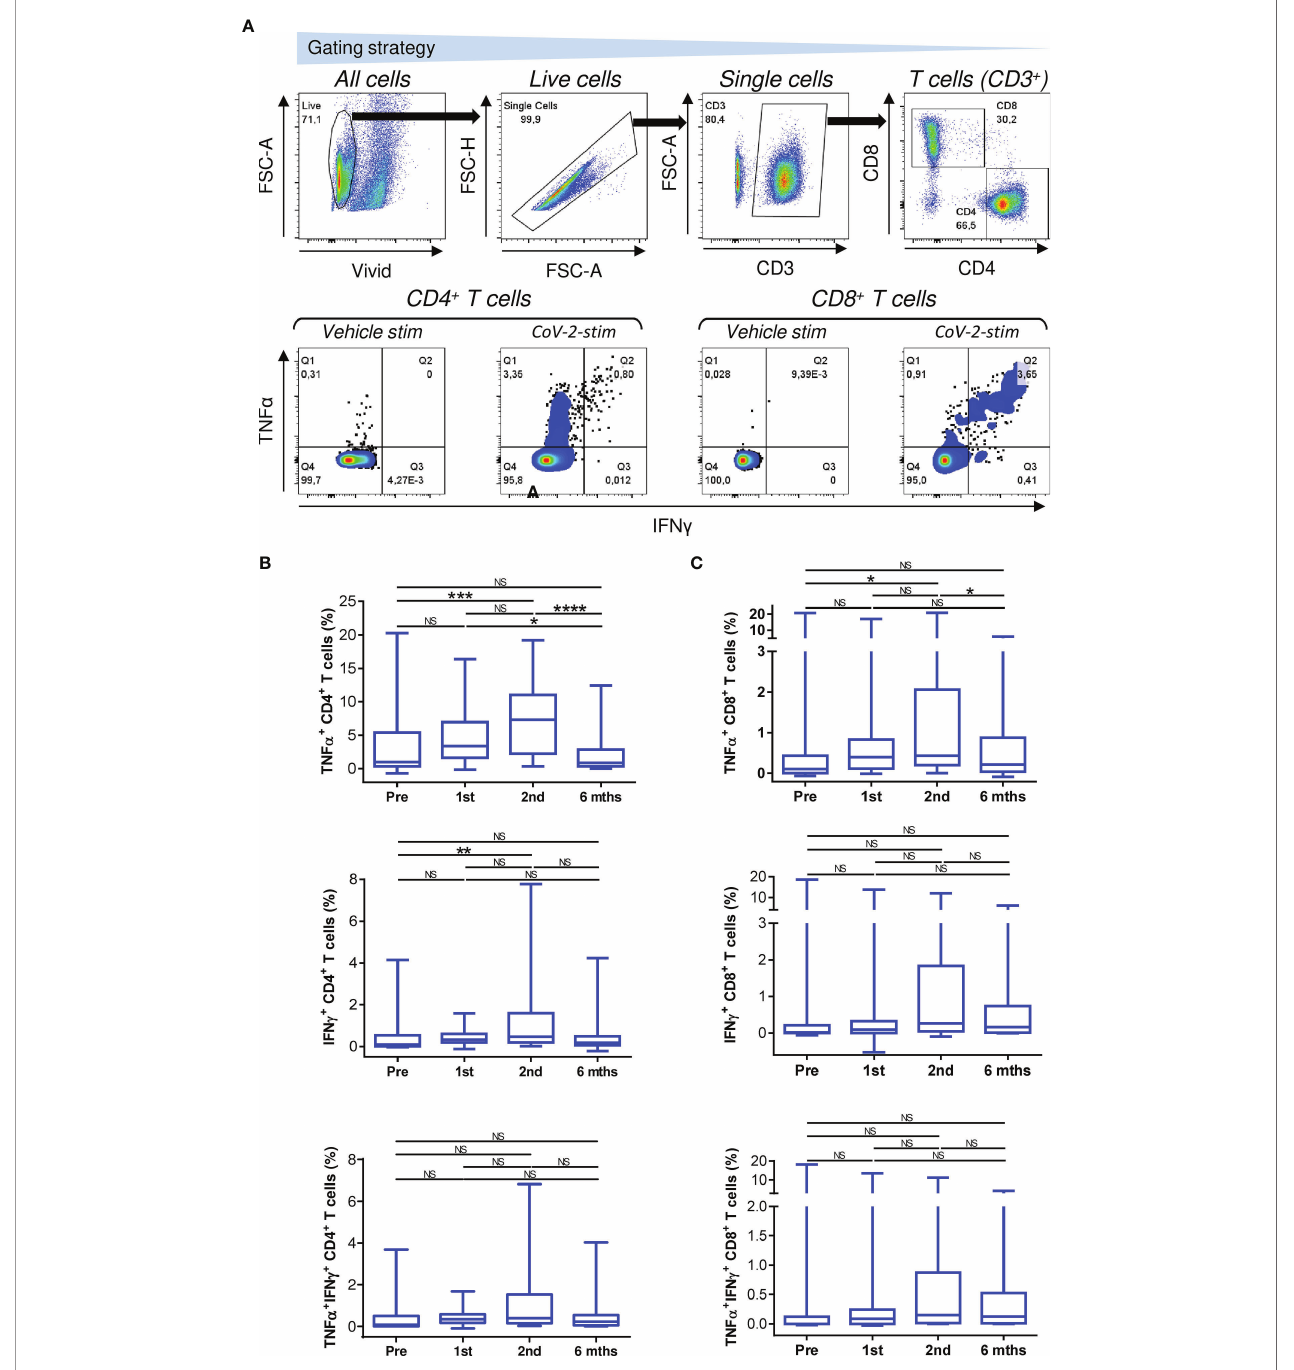
FIGURE 2 | Reactivity of enriched PBMCs to SARS-CoV-2 spike glycoprotein peptides. (A) The gating strategy for fl ow cytometry data ( top panels ). The frequencies of TNF a -, IFN g -, or TNF a /IFN g -producing CD4 + and CD8 + T cells in enriched PBMCs stimulated with vehicle (Vehicle-stim) or SARS-CoV-2 spike glycoprotein-derived peptides (CoV-2-stim) ( bottom panel s) determined by intracellular cytokine staining. The frequency of each peptide-reactive cytokine-producing T-cell population was calculated as the difference in the frequency of the cytokine-producing T cells between the vehicle- and peptide-stimulated samples. (B, C) The frequencies of peptide-reactive TNF a -, IFN g -, or TNF a /IFN g -producing CD4 + (B) and CD8 + (C) T cells before the fi rst (Pre) and second (1st) vaccine doses were administered and 4 weeks (2nd) and 6 months (6 mths) after the second vaccine dose was administered. In B – C, box and whisker plots (2.5 – 97.5 percentile) are shown, and the signi fi cance of differences among the groups (Pre, 1st, 2nd, and 6 mths) is indicated ( NS p > 0.05, * p < 0.05, ** p < 0.01, *** p < 0.001, **** p < 0.0001; n = 34; matched-pair one-way ANOVA with Dunn ’ s